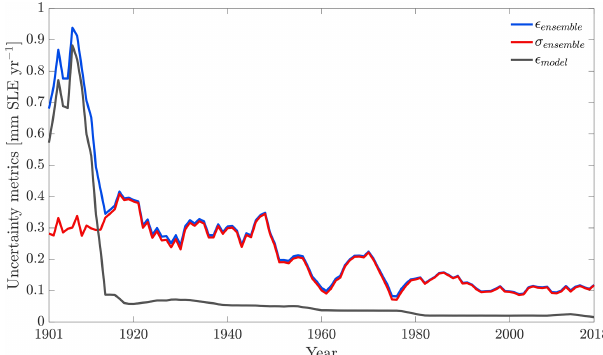
Figure 5. Five-year moving average of the temporal evolution of model uncertainty metrics for annual global mass change